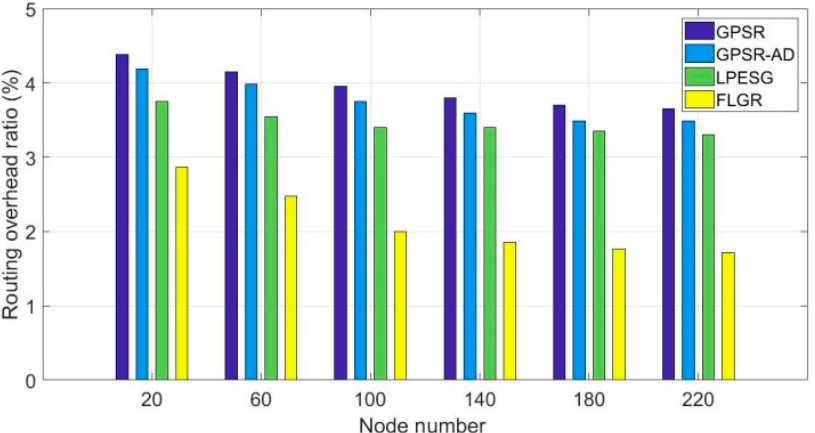
Figure 12. Impact of node number on routing overhead ratio with v max =